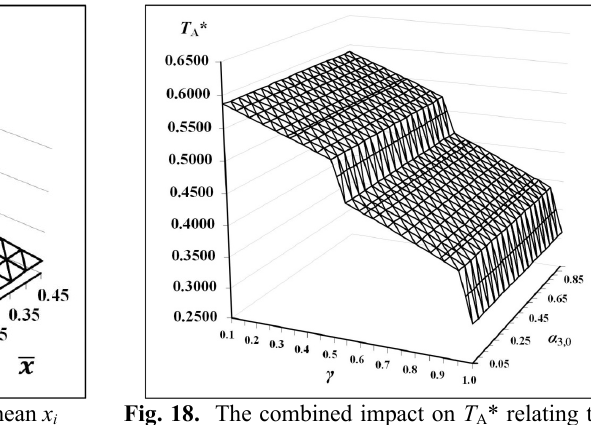
Fig. 15. The combined influences on E [ TCU ( T A *, n *)] relating to α 1,0 and mean x i